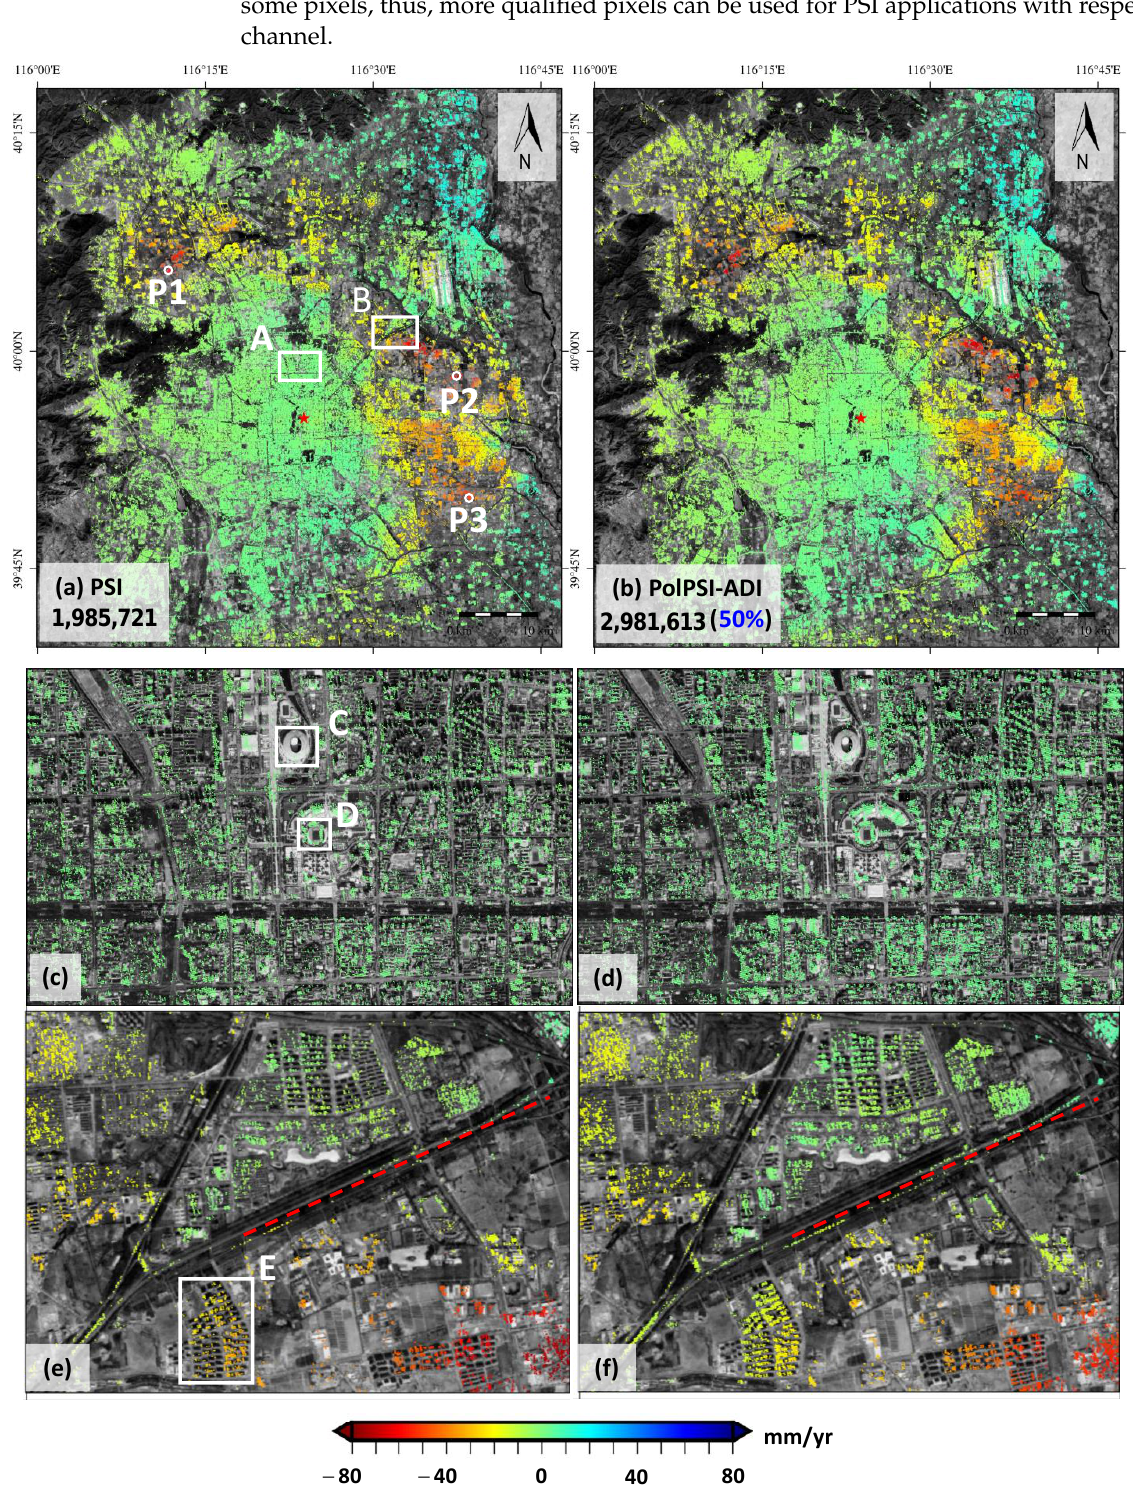
Figure 6. Ground deformation velocity (in the line-of-sight direction) estimated by the ( a ) PSI and ( b ) PolPSI-ADI algorithms, respectively. The numbers in ( a , b ) represent respectively the final numbers of PS pixels obtained by the two approaches, and the improvement percentage in the bracket in ( b ) is calculated by taking the PSI method as a reference. ( c , e ) are the PSI derived results over the two subareas limited by the rectangle A and B in ( a ). ( d , f ) are the counterparts of ( c , e ) derived by the PolPSI-ADI